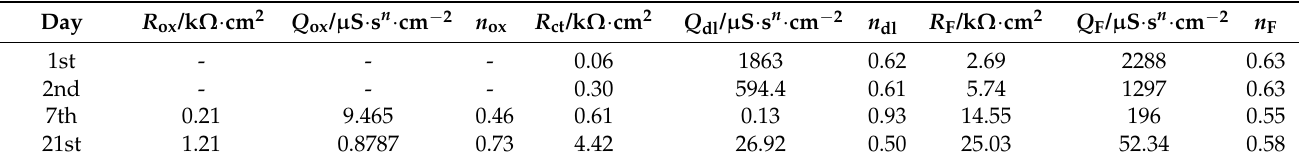
Table 2. EIS data for CuSn12 for continuous immersion in simulated acid rain at pH 5.